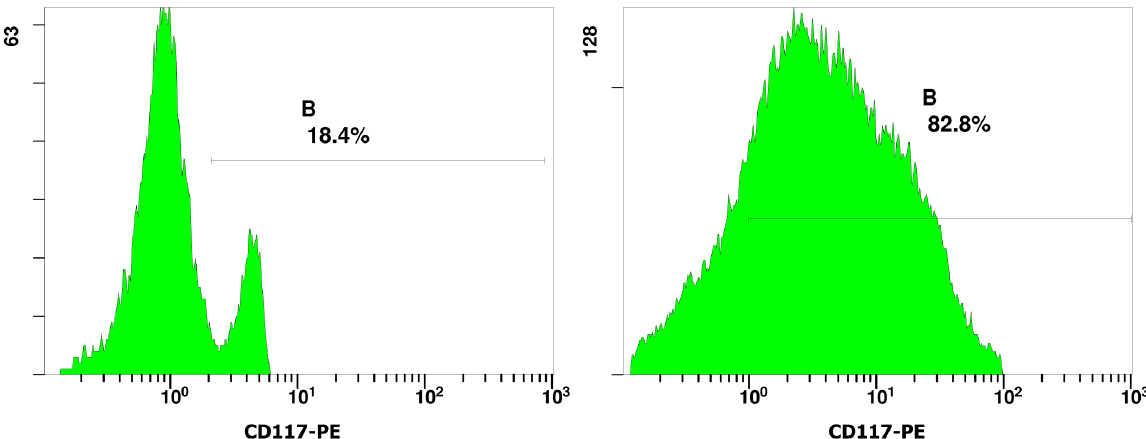
Figure 2. Immunophenotyping of CD117 + yolk sac cells. Representative flow cytometric data from more than three independent analyses were shown. The cells were fluorescently stained with CD117-PE. To show the CD117 + cell purity, CD117 + yolk sac cells before separation were shown on the left panel; CD117 + yolk sac cells after separation by using the anti-murine CD117 antibodies conjugated to mini-magnetic beads were shown on the right panel.